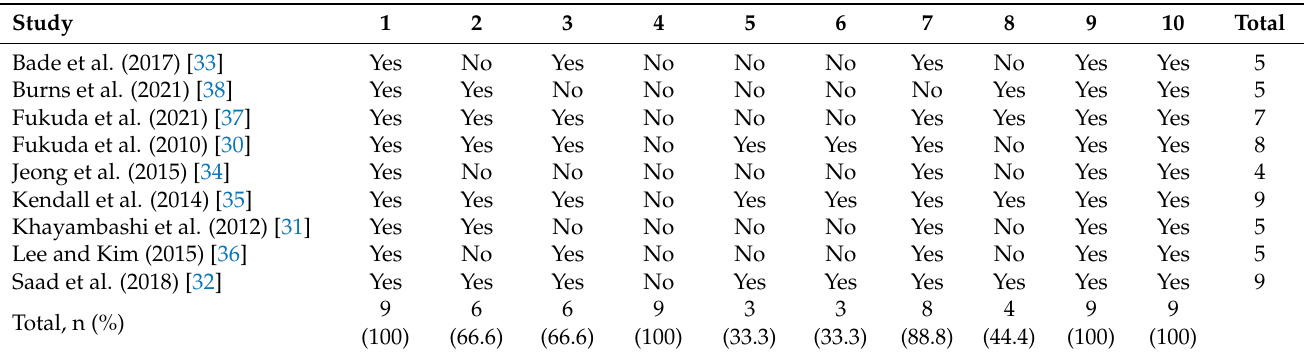
Table 2. PEDro Scale Scores for individual trials * (n =